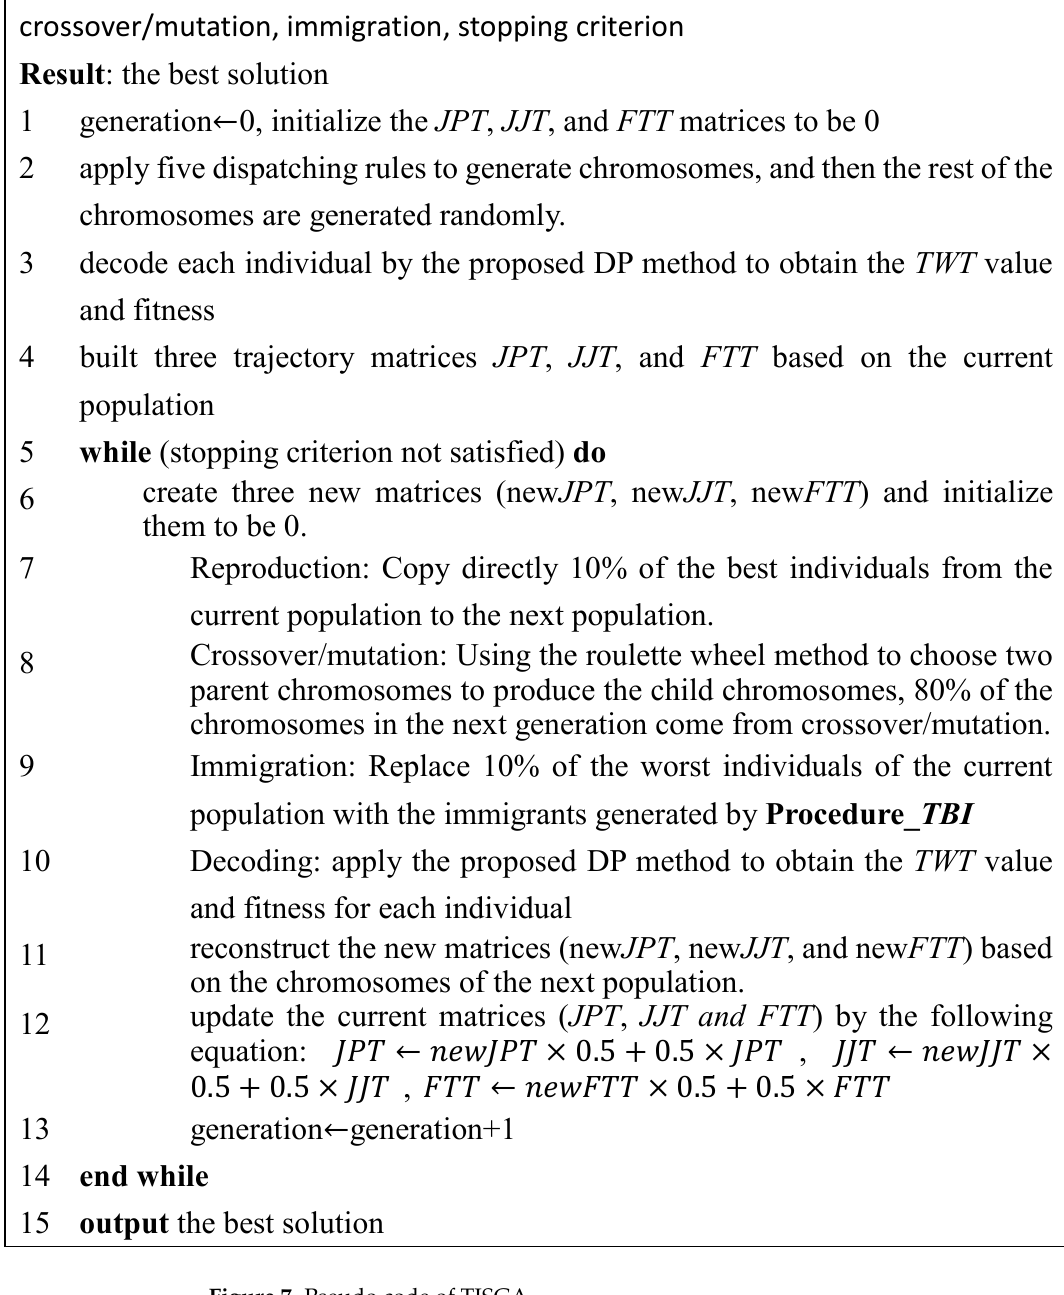
Figure 7. Pseudo code of TISGA.